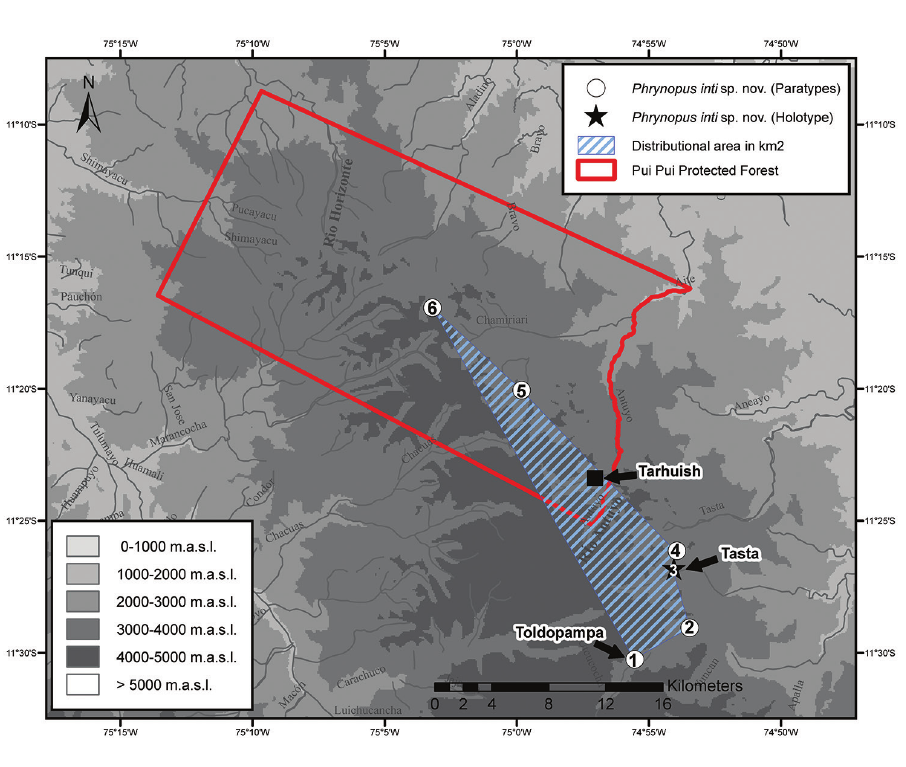
Figure 2. Pui Pui Protected Forest indicated in red outline with collecting sites (1–6) of Phrynopus inti sp. n. , star indicating type locality, and the estimated distributional area of 101.3 km 2 in blue. 1 = Toldo- pampa valley, 3670 m a.s.l., 2 = Satipo-Toldopampa Road at km 134, 3350 m a.s.l., 3 = Quebrada Tasta, 3609 m a.s.l., 4 = Polylepis forest patch near trail from Tasta to Tarhuish, 3886 m a.s.l., 5 = Antuyo, 3700 m a.s.l., 6 = close to Laguna Sinchon, 3890 m a.s.l. Map by J.C.